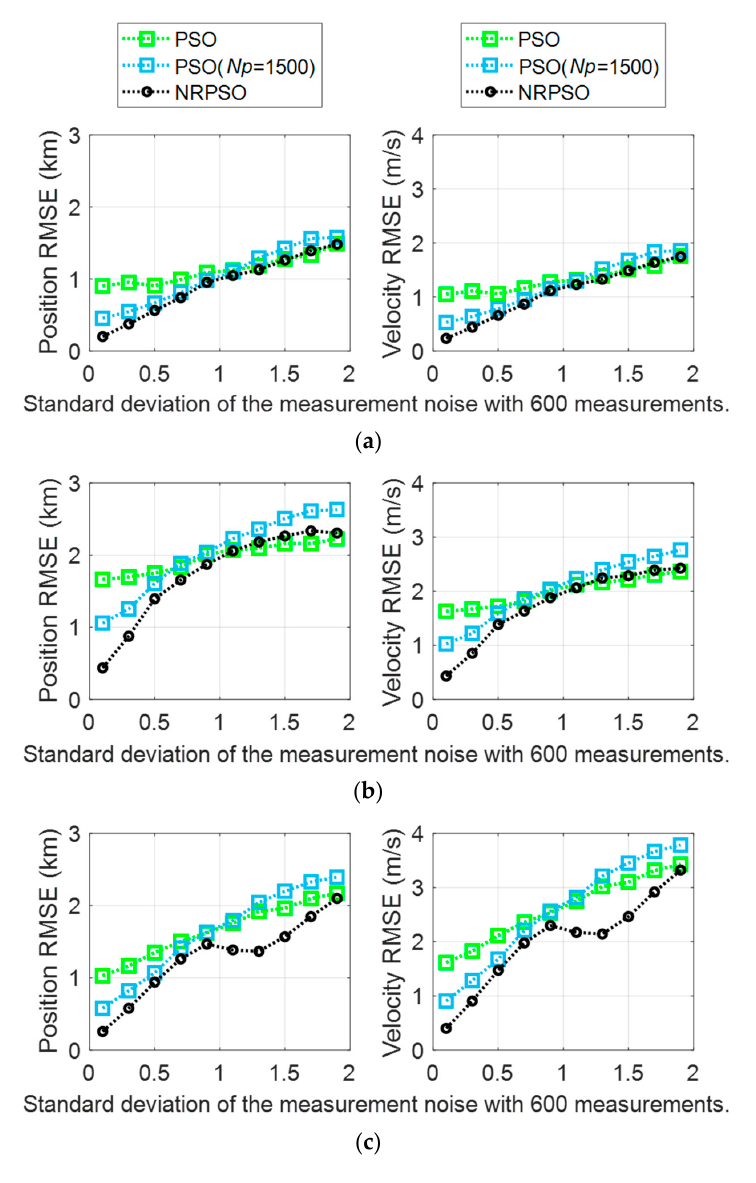
Figure 6. BO-TMA results versus measurement noise standard deviation for ( a ) Target 1, ( b ) Target 2, and ( c ) Target 3. The results of PSO ( Np = 400), PSO ( Np = 1500), and NRPSO ( Np = 400) are represented by green, blue, and black, respectively. The left column indicates the position RMSE, and the right column shows the velocity